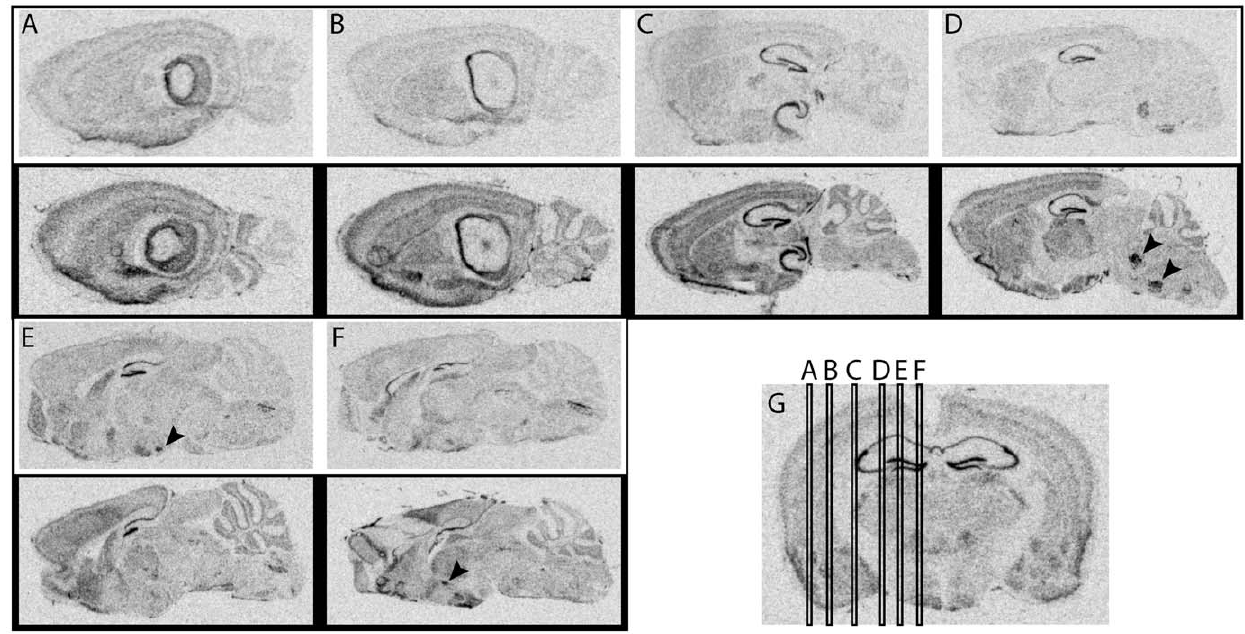
Figure 1. Qualitative overview of fkbp5 mRNA expression in sagittal slices. ( A ) – ( F ) Selected slices throughout the brain. ( D ) Black arrowheads point at the motor nuclei of the nervus trigeminus and nervus facialis . ( E ) Black arrowhead highlights the premammilary nucleus. ( F ) Black arrowhead shows the hypothalamic PVN. ( G ) Coronal overview depicting the level of the selected slices. Autoradiographs with a white frame were from the control condition, autoradiographs with a black frame were from the FD condition.